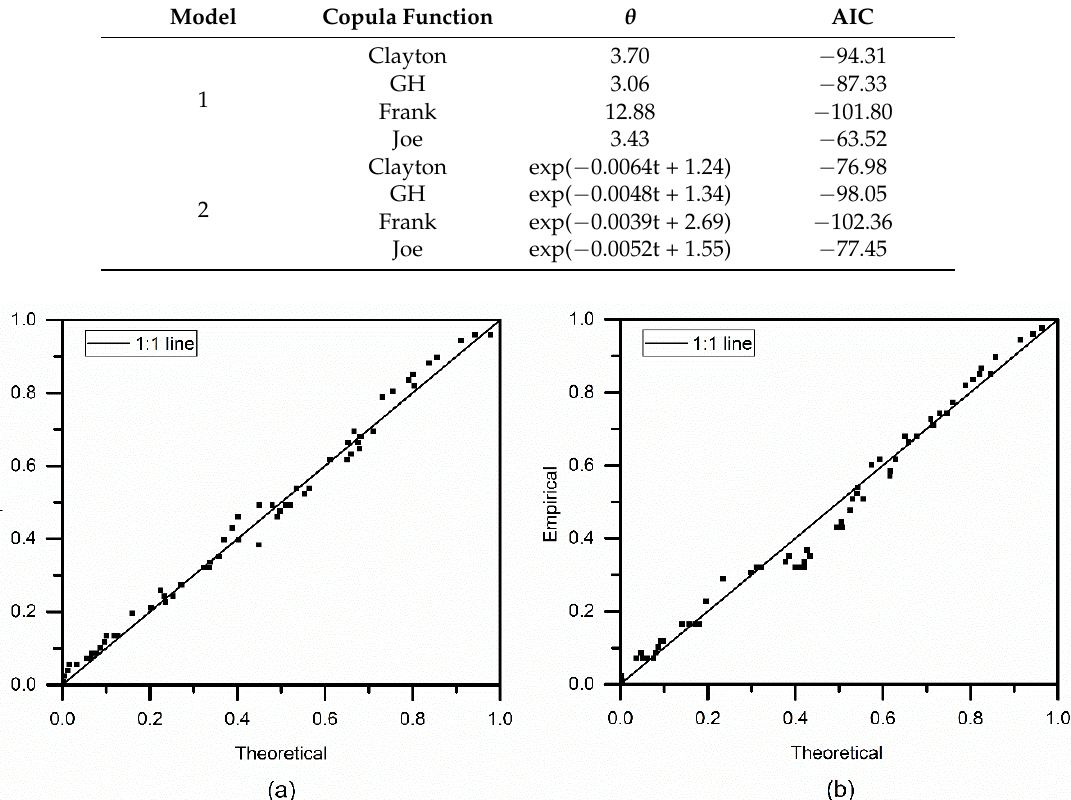
Figure 4. A comparison of empirical and theoretical probabilities for the Frank copula ( a ) under the stationary condition and ( b ) under non-stationary condition.